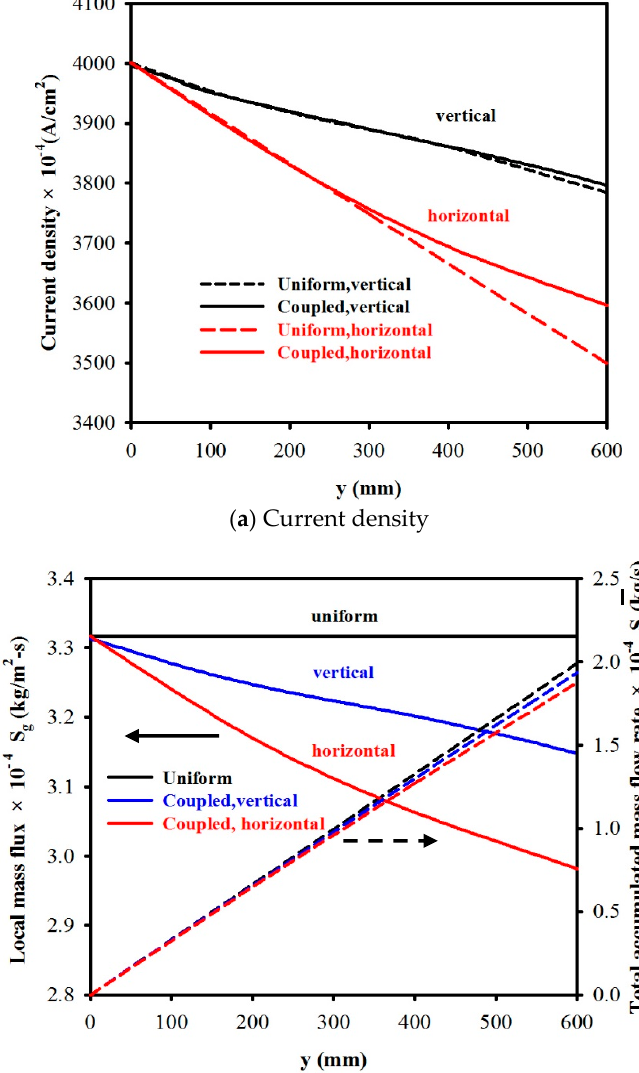
Figure 7. A comparison of current density and the release of mass flux for the oxygen and total accumulated mass flow rate along electrode y for coupled and de-coupled electric and velocity fields, with v in = 0.4 m/s.